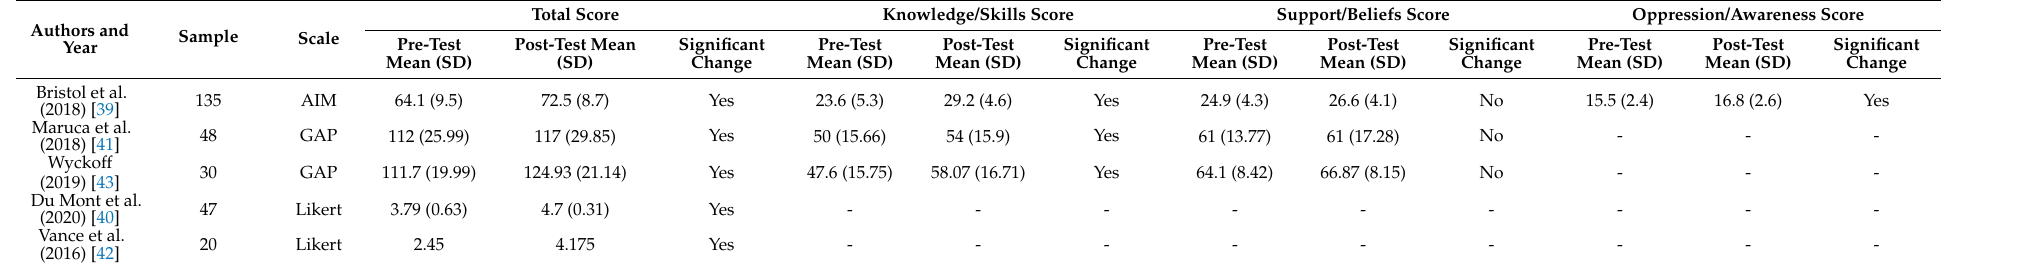
Table A1. The results of quasi-experimental pre-test-post-test studies selected for the